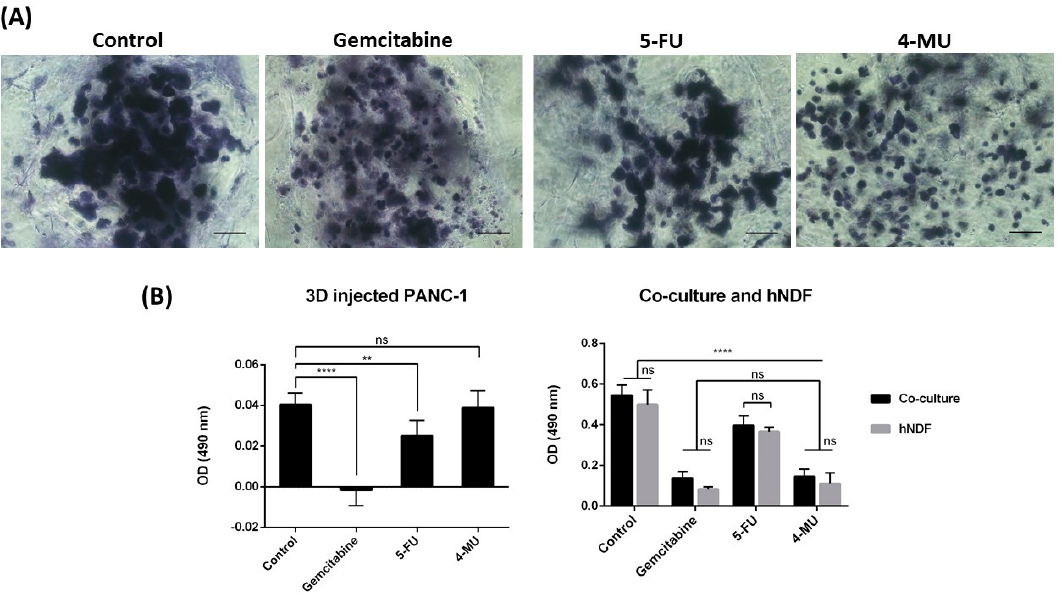
Figure 4. Effect of Gemcitabine, 5-FU, and 4-MU on the 3D co-culture system. ( A ) Toluidine blue staining of 3D co-cultures. Cellular density at day 4 was evaluated using toluidine blue staining. Scale bar: 100 µm. ( B ) MTS assay. MTS was performed on PANC-1 injected in an empty gel ( left ) and on co-cultures and hNDF monocultures ( right ). N = 3, n = 3.